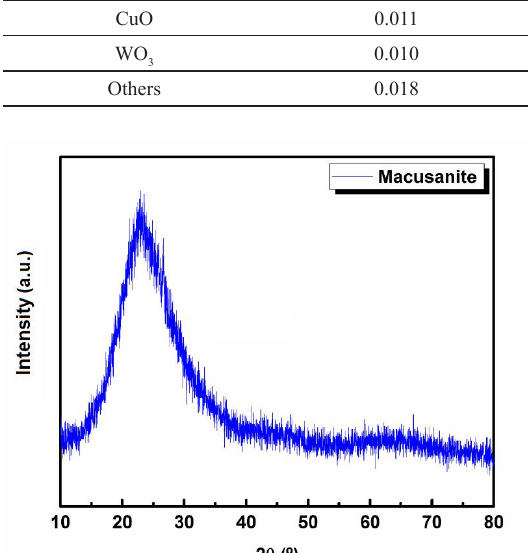
Figure 7. X-ray Diffraction analysis of